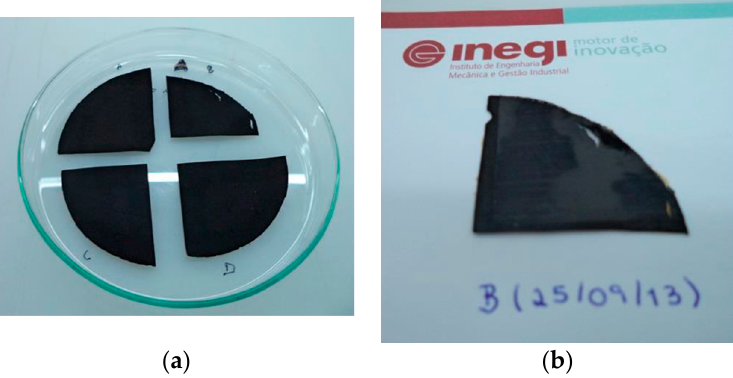
Figure 8. Photos of the buckypaper before ( a ) and after ( b ) impregnation and curing.